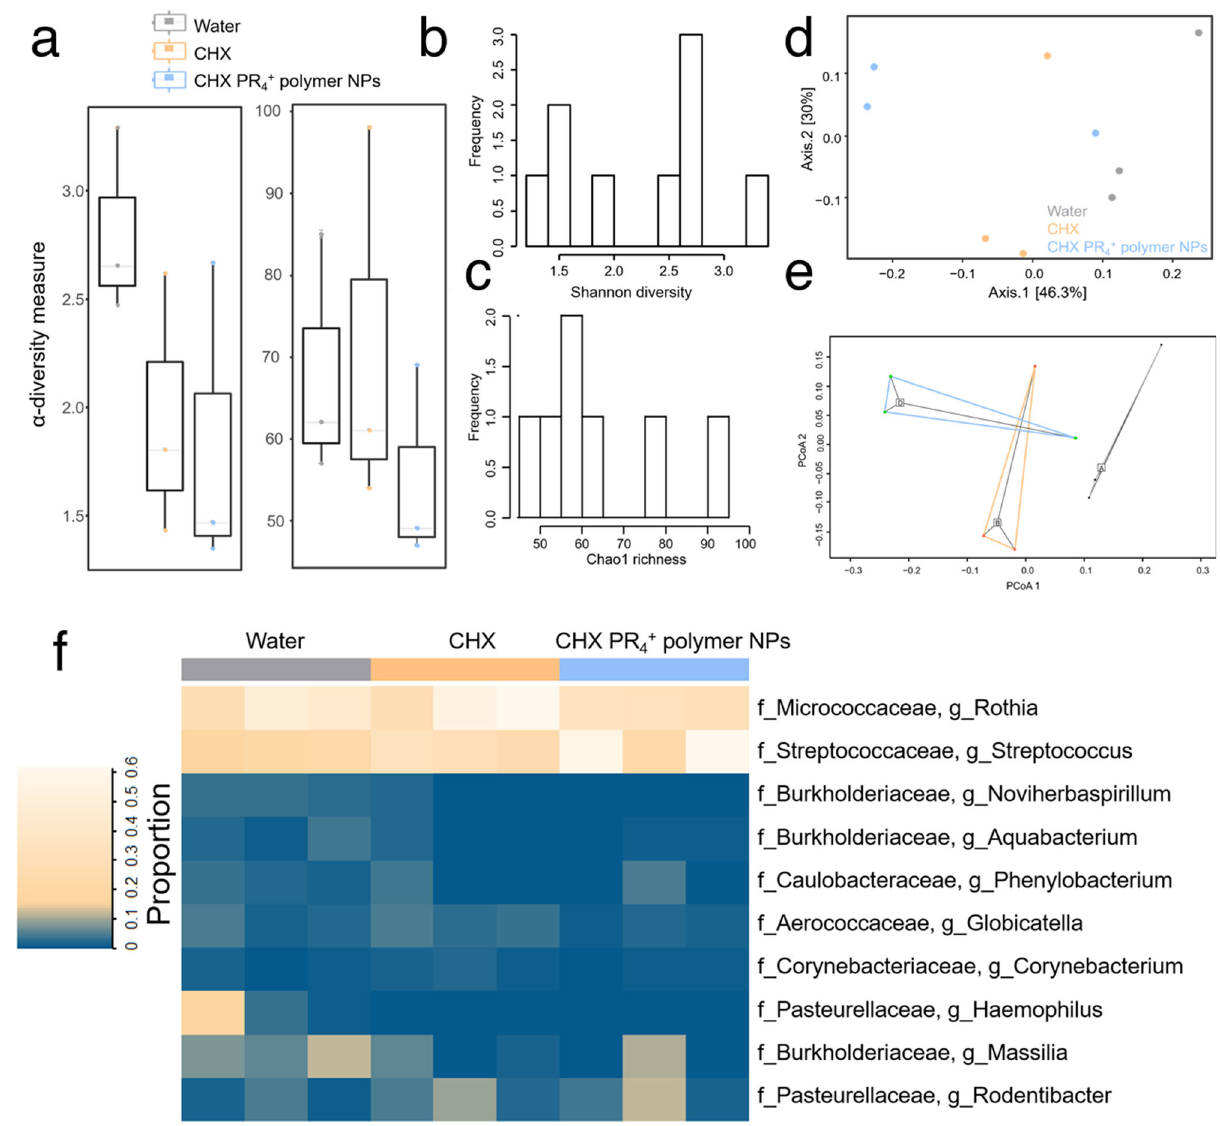
Fig. 8 The assessment of the oral micro fl ora of the rats ( n = 3 per group) treated with various formulations. a Shannon α -diversity index and Chao 1 richness index for different groups; b Shannon α -diversity index and c Chao 1 richness normal distribution test; d PCA ordination plot of the oral microbiota in various groups, where the distance between each point indicates the difference between those samples; e Bray – Curtis principal coordinate analysis (PCoA), which indicates the β -diversity in each group; the analysis revealed that there are no signi fi cant differences among the groups based on their Bray – Curtis distances, and the PERMANOVA and ANOSIM tests have p value > 0.05 and in both cases; f the heatmap indicates the bacterial taxa found in all samples according to treatment type, and there are no signi fi cant differences in the proportions of each genus among the